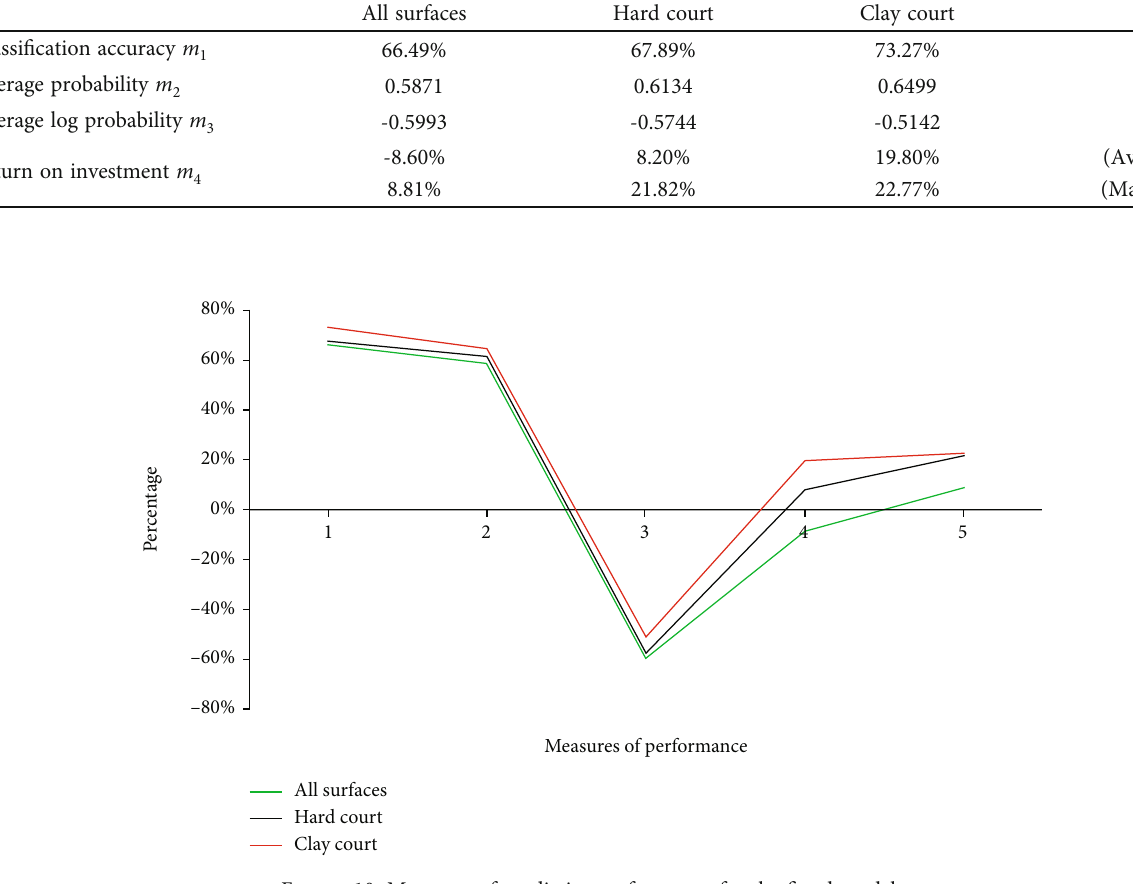
Figure 10: Measures of predictive performance for the fi tted